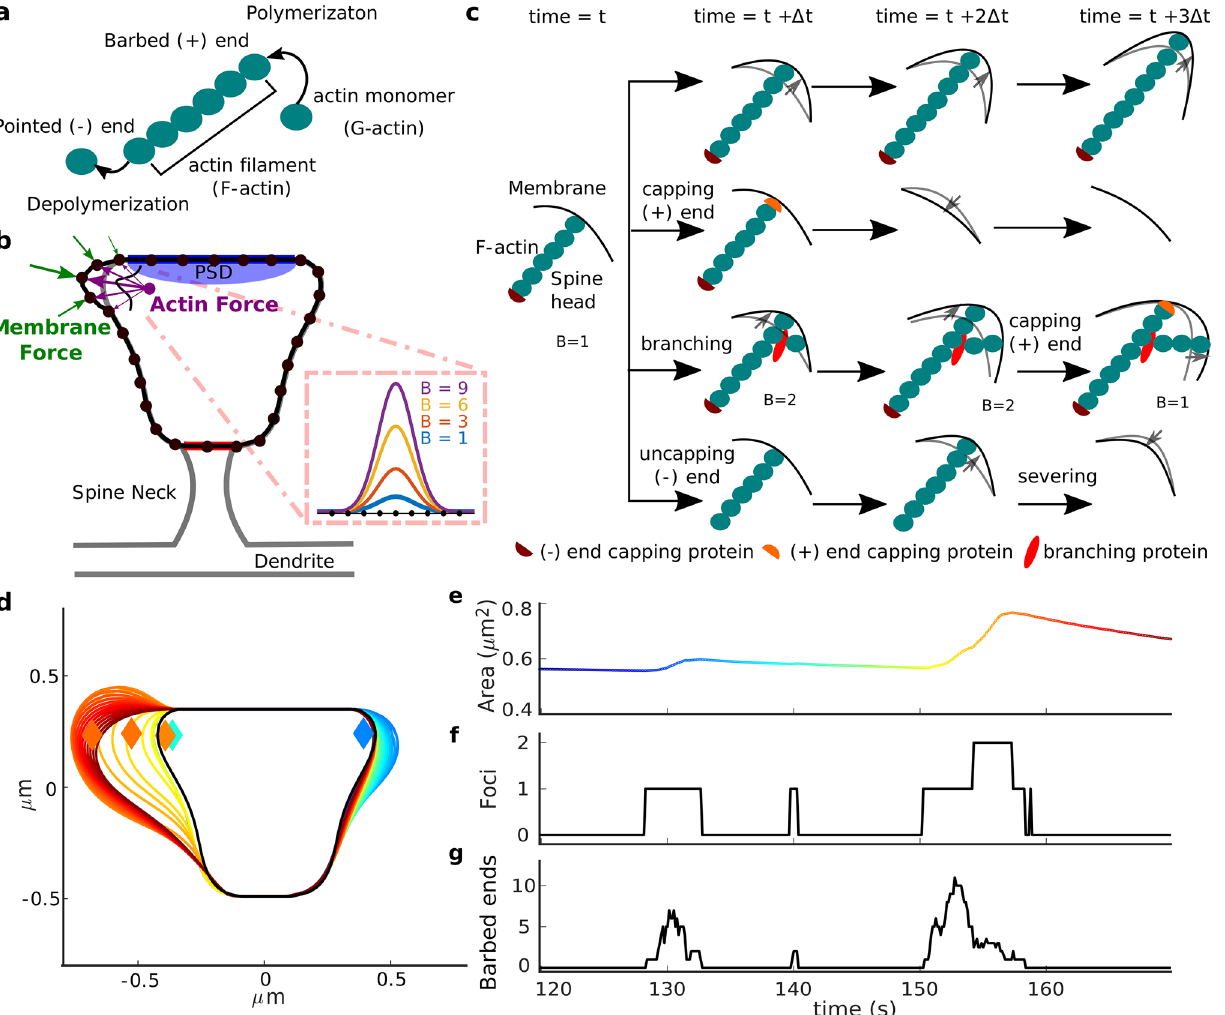
Figure 1. Description of the theoretical model. The mechanisms that displace and change PSD and spine neck are not shown in this figure. ( a ) Descripiton of the actin treadmilling process. ( b ) Characterization of the force interactions in a dendritic spine head. Black dots are the mesh approximation for the membrane. Arrows represent the forces exerted by the membrane and actin polymerization, in green and purple, respectively. The purple dot signals the nucleation location of an actin polymerization focus. The vertices representing the PSD and neck are highlighted in blue and red. The inset shows the Gaussian kernels for different number of barbed ends B . ( c ) Filament events for 4 time-steps (columns), each row shows a different scenario. Changes in membrane are denoted by gray arrows. At each time-step, all filaments with uncapped (+) end, barbed end B , undergo monomer addition and the membrane is expanded, as shown in the first row. However, monomer addition at the (+) end stops when it is capped by a capping protein (second row). Thereupon, the actin filaments do not polymerize and hence, the membrane eventually recovers its initial shape because there is no force pushing it forward. Besides these events, actin filaments with barbed ends can branch, and thus, B B 1 (third row). Also, the actin filament capped (−) ends can be uncapped by removing the capping → + protein. Uncapped minus ends are eventually severed, which eliminates the filament and thus, the membrane is no longer deformed (fourth row). ( d ) Spine shapes arising from model simulation, color-code according to time as in ( e ). Black line represents the “resting” shape to which the spine shrinks in the absence of actin force (see “Methods”). Diamonds represent actin nucleation locations, initiated at different times (color-coded). ( e ) Area evolution of the spine, color-coded from initial (in dark blue) to final time. ( f ) Number of polymerization foci during this period. ( g ) Number of uncapped (+) ends, at the polymerization foci over time. See “Methods” for further